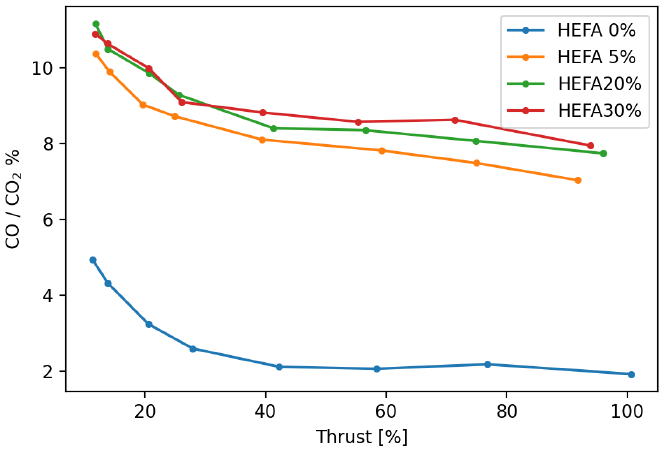
Figure 34. DGEN 380/HEFA: CO vs. CO 2